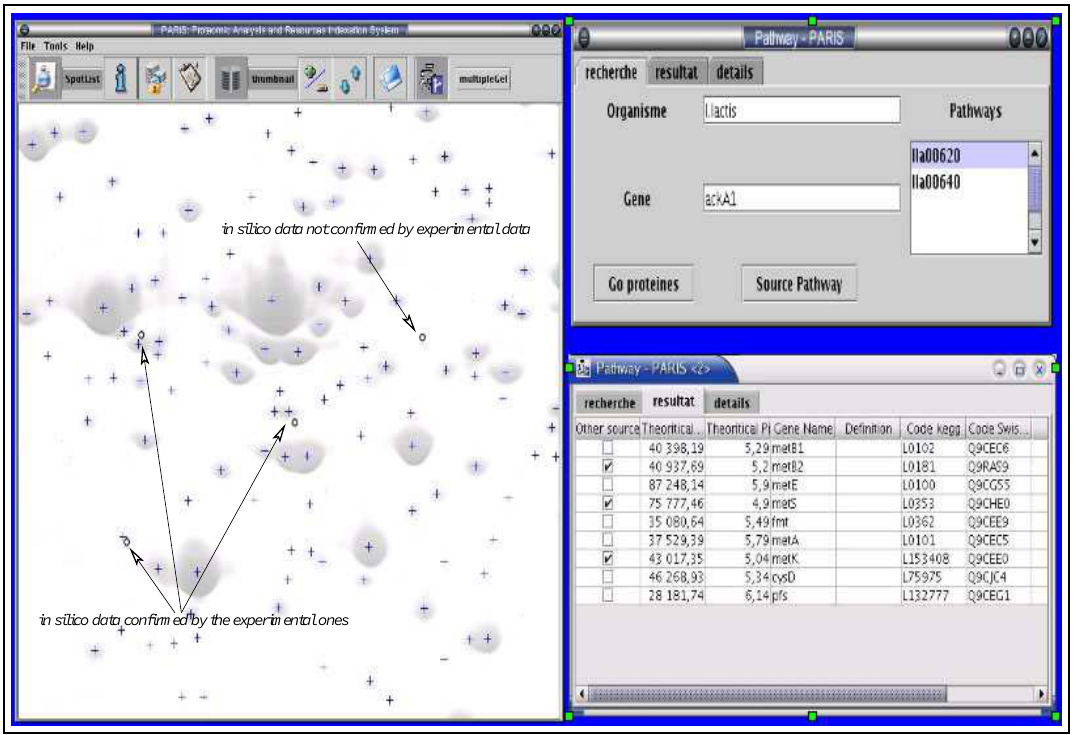
Figure 7: Data integration with PARIS. We illustrate here an example of how to use pathway information found in KEGG to analyze the gel centered data. In this example, the experiment generated data are marked by a cross and the in silico generated data are marked by a